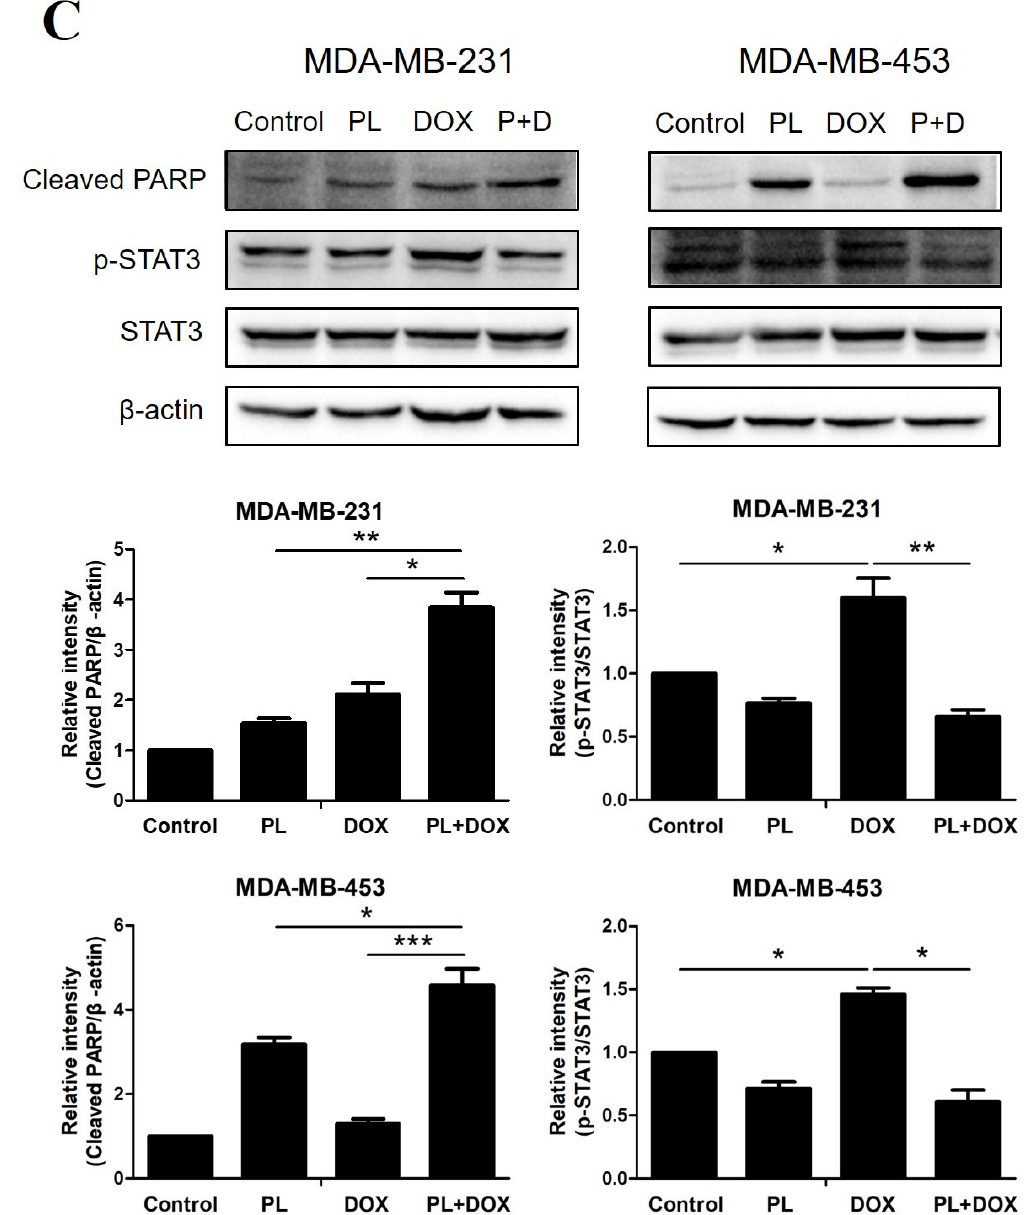
Figure 5. Piperlongumine and doxorubicin synergistically induce apoptosis and inhibit p-STAT3 in TNBC cells. ( A ) Both MDA-MB-231 and MDA-MB-453 cells were treated with DMSO, 5 µ M PL, 0.5 µ M DOX, or with a combination for 48 h. Cells were then harvested and stained with Annexin V / PI. The apoptotic rate was detected by flow cytometry. ( B ) Cells in the Annexin V-positive area were considered apoptotic. ( C ) Both TNBC cell lines were treated with DMSO, 5 µ M PL, 0.5 µ M DOX, or with a combination for 24 h. Cell lysates were then subjected to Western blot analysis. Cleaved PARP, p-STAT3, and STAT3 levels were measured. β -actin was used as an internal control. * p < 0.05, ** p < 0.01, *** p < 0.001 compared to the compared group.